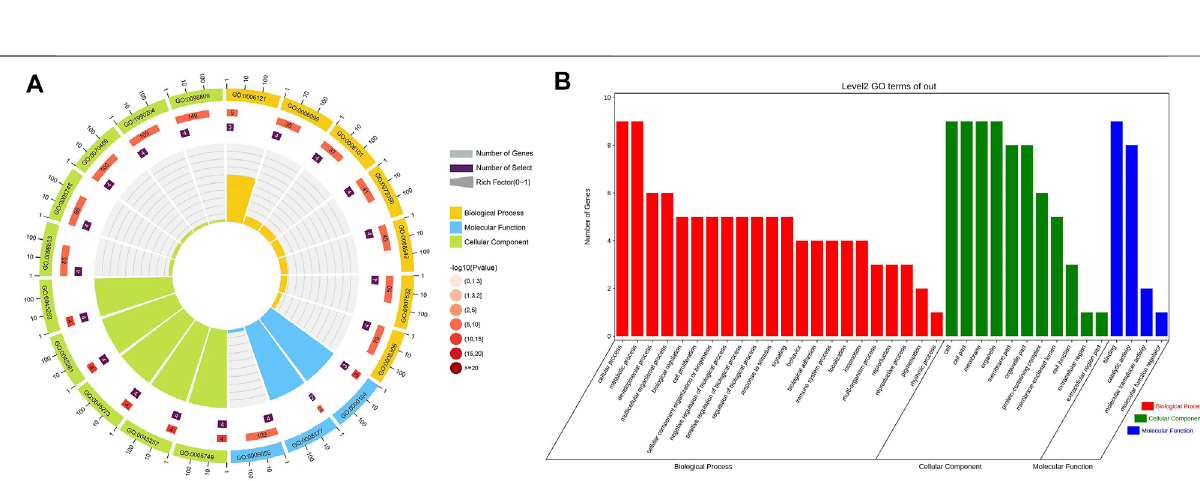
Frontiers in Genetics |